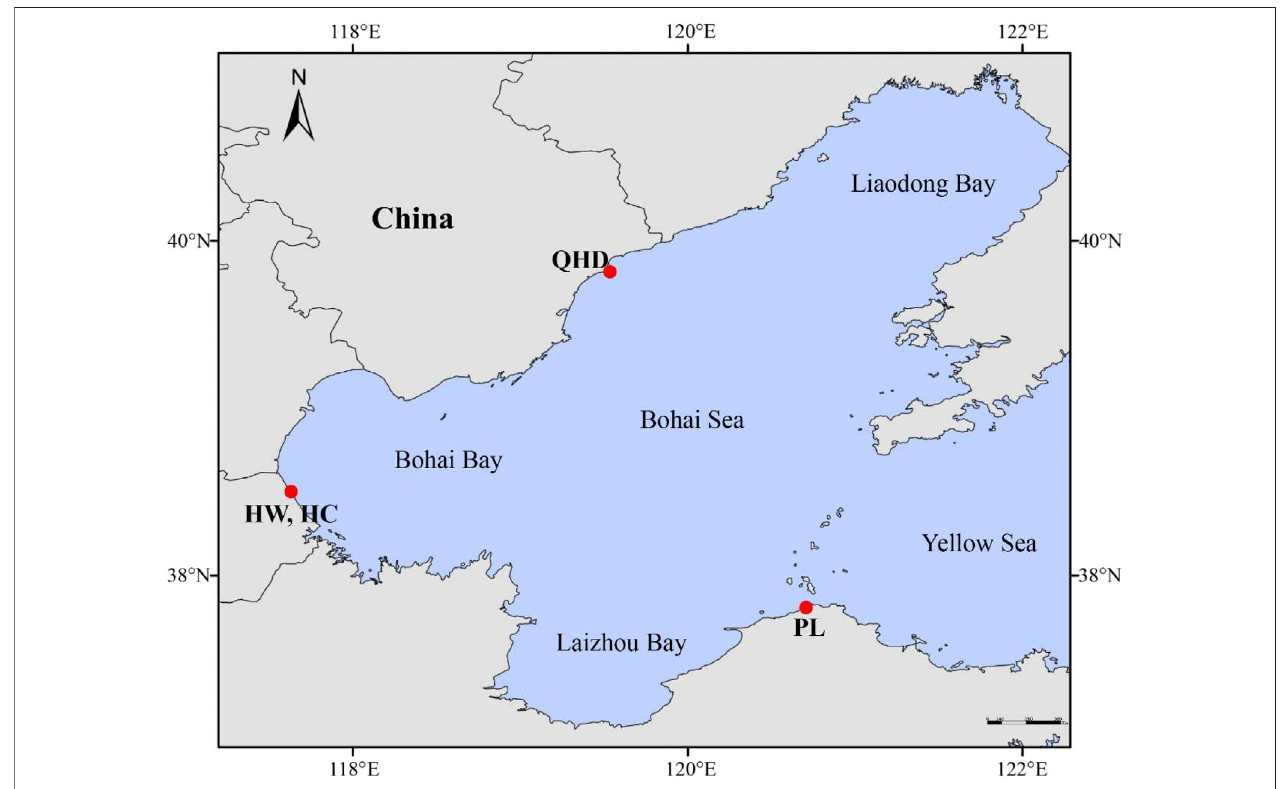
FIGURE 1 | Collection map of P. trituberculatus